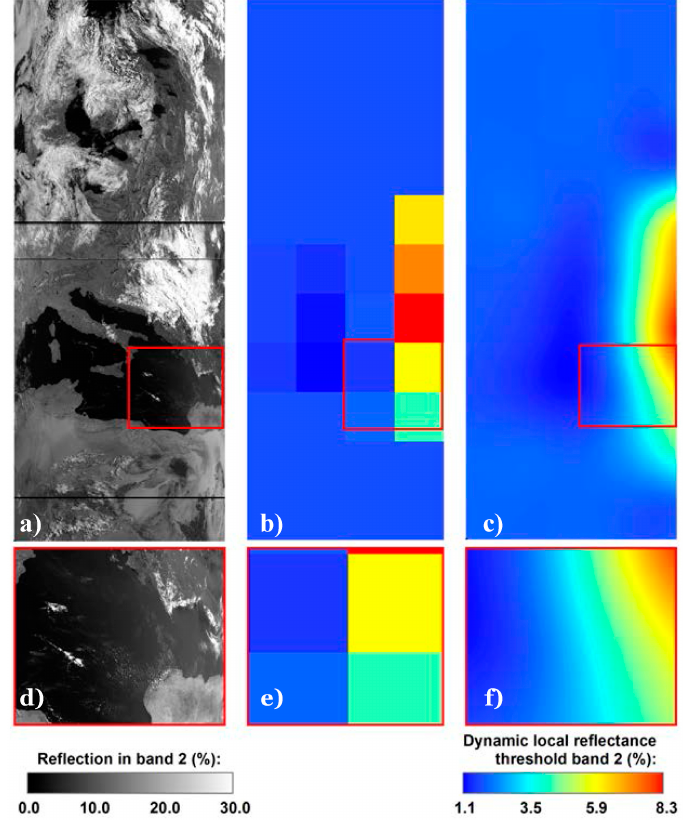
Figure 6. Example for band 2 reflectance ( a ) of an AVHRR orbit from July 1991 (NOAA-10), the threshold grid as derived locally for 512 × 512 pixel subsets ( b ); as well as the minimum curvature surface of the threshold for water body classification ( c ); Subsets ( d – f ) show details of the elements atop.